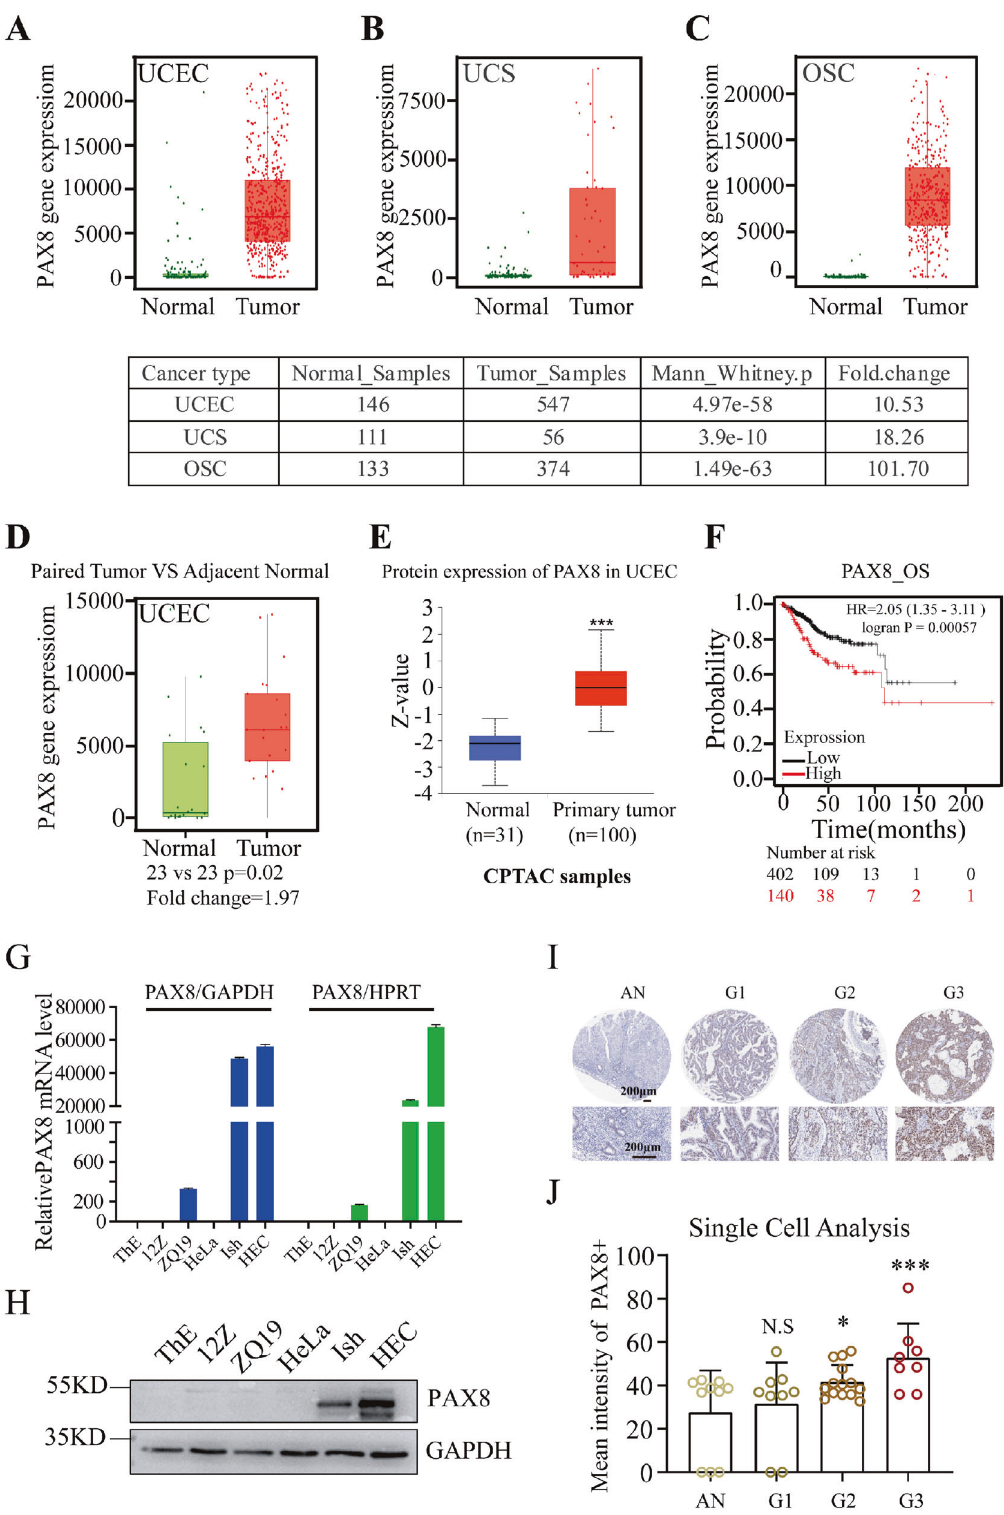
including ThESCs (a benign endometrial stromal cell line), 12Z (a benign endometrial epithelial cell line), ZQ19 (a benign primary endometrial stromal cells), HeLa (cervical adenocarcinoma cell line) and two UCEC cell lines (Ishikawa and HEC-1B). Of the examined cell lines, two UCEC cell lines harboring signi fi